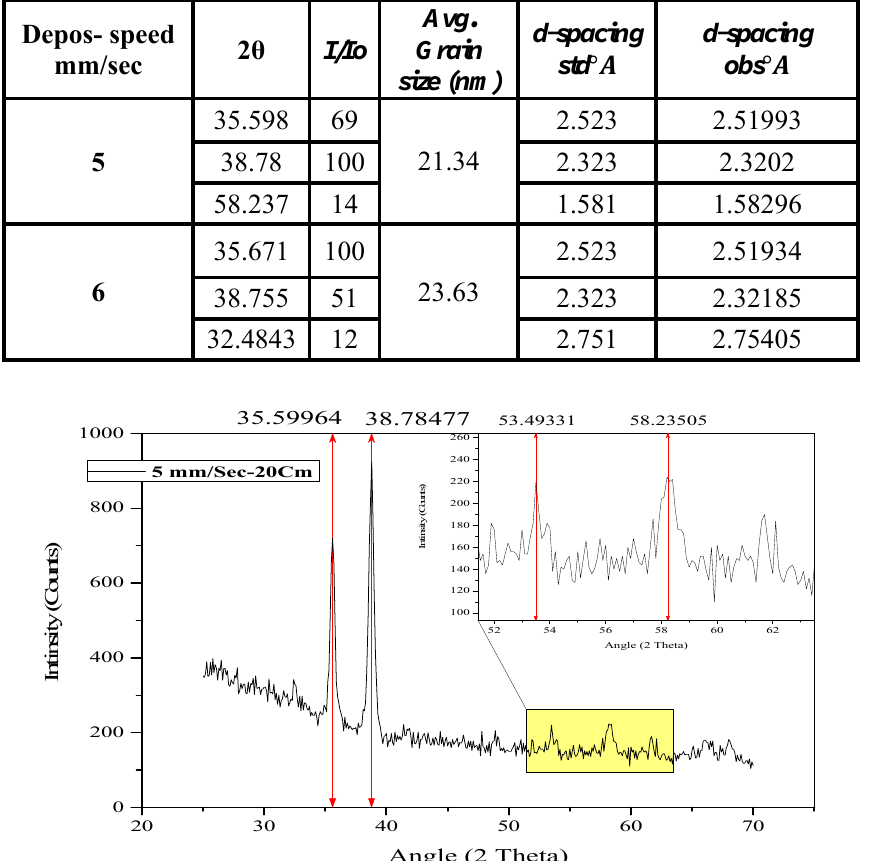
Fig. 1a: XRD pattren of CuO layer prepared at 5 mm/sec.